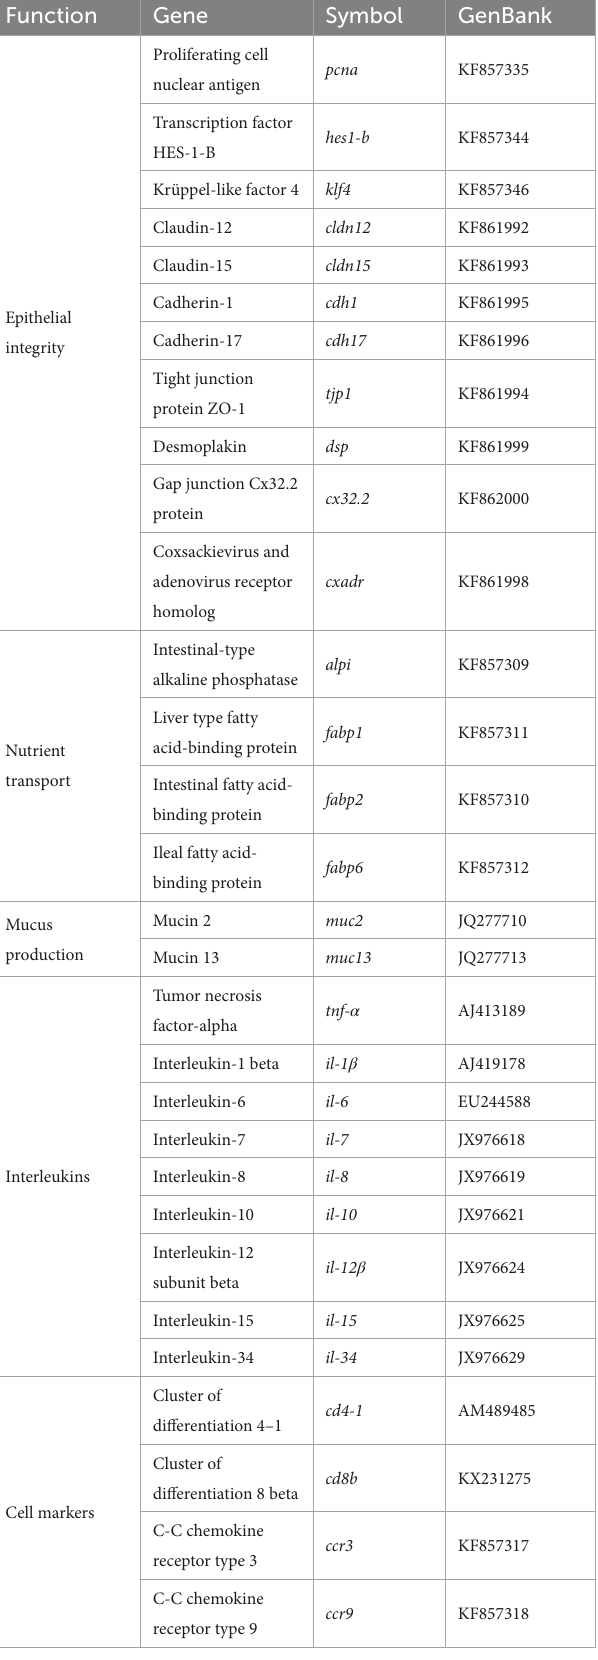
TABLE 2 PCR-array layout for gene expression profile of the intestine of gilthead seabream ( Sparus aurata ) fed experimental diets.